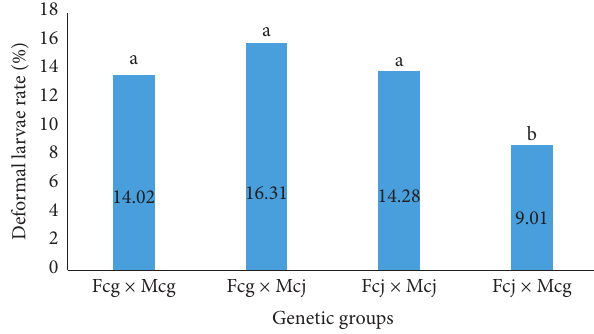
Figure 3: Deformed larvae rates at the end of hatching in the re- ciprocal hybridizations of Clarias gariepinus × Clarias jaensis under controlled conditions. a, b: histograms bearing the same letters are not significantly different ( p > 0 . 05). The female was named